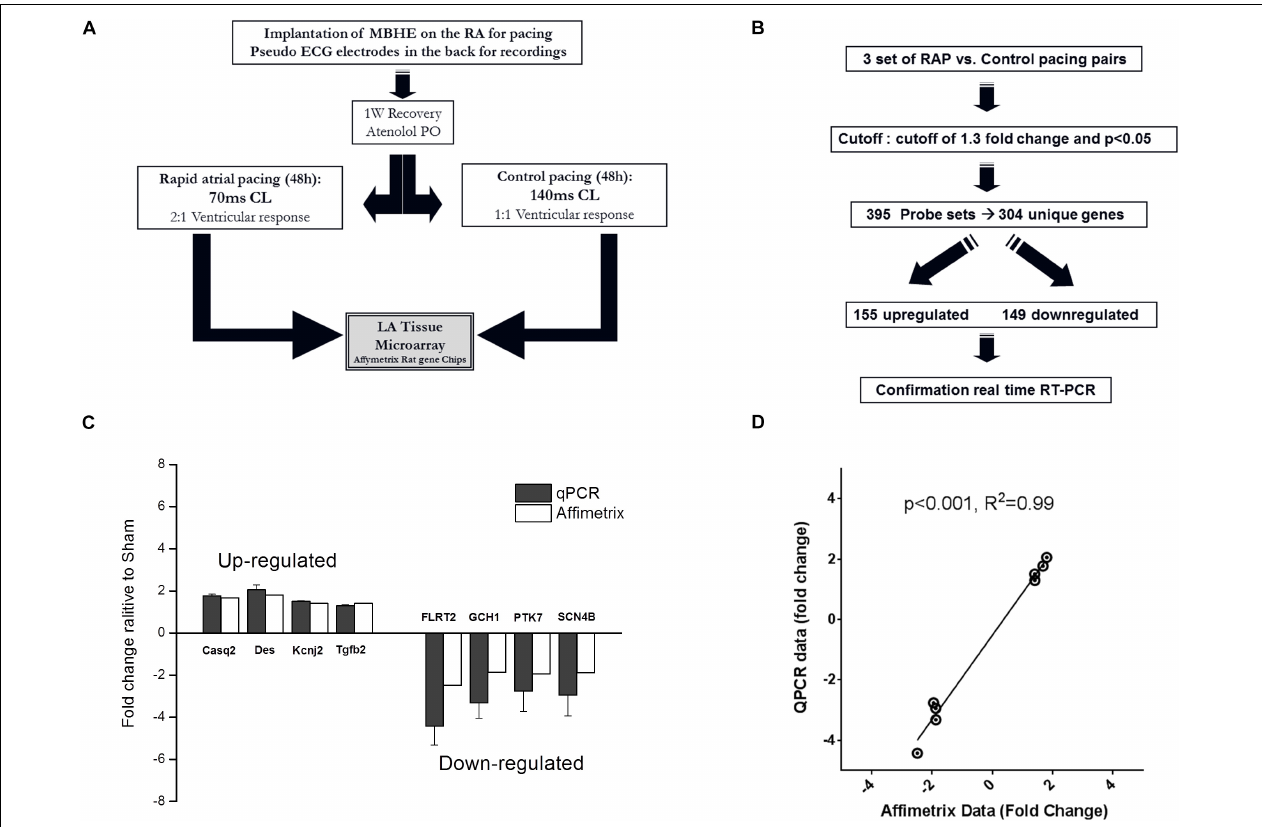
FIGURE 4 | Paradigm for evaluation of transcriptional effects of RAP on left atrial tissue of rats. (A,B) Schematic diagrams of microarray study design and basic outcome. (C,D) RT-qPCR for eight genes of interest indicating data